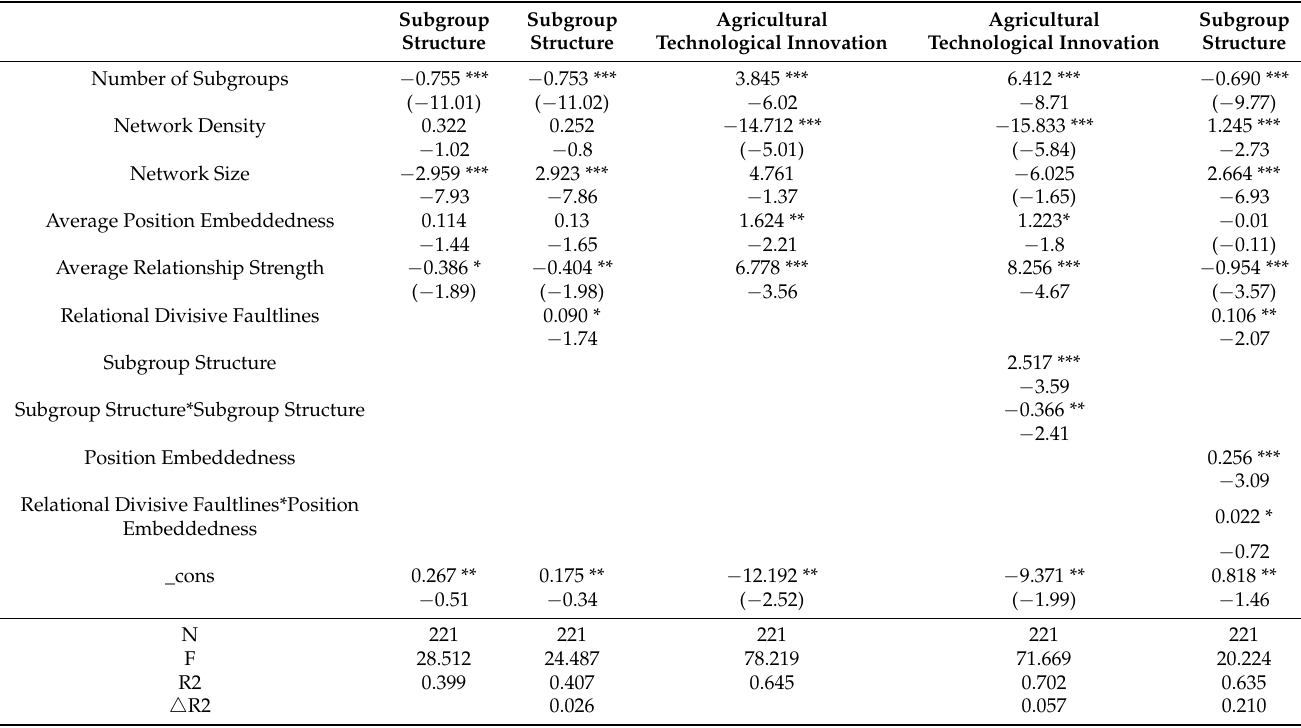
Table 4. Results of Regression